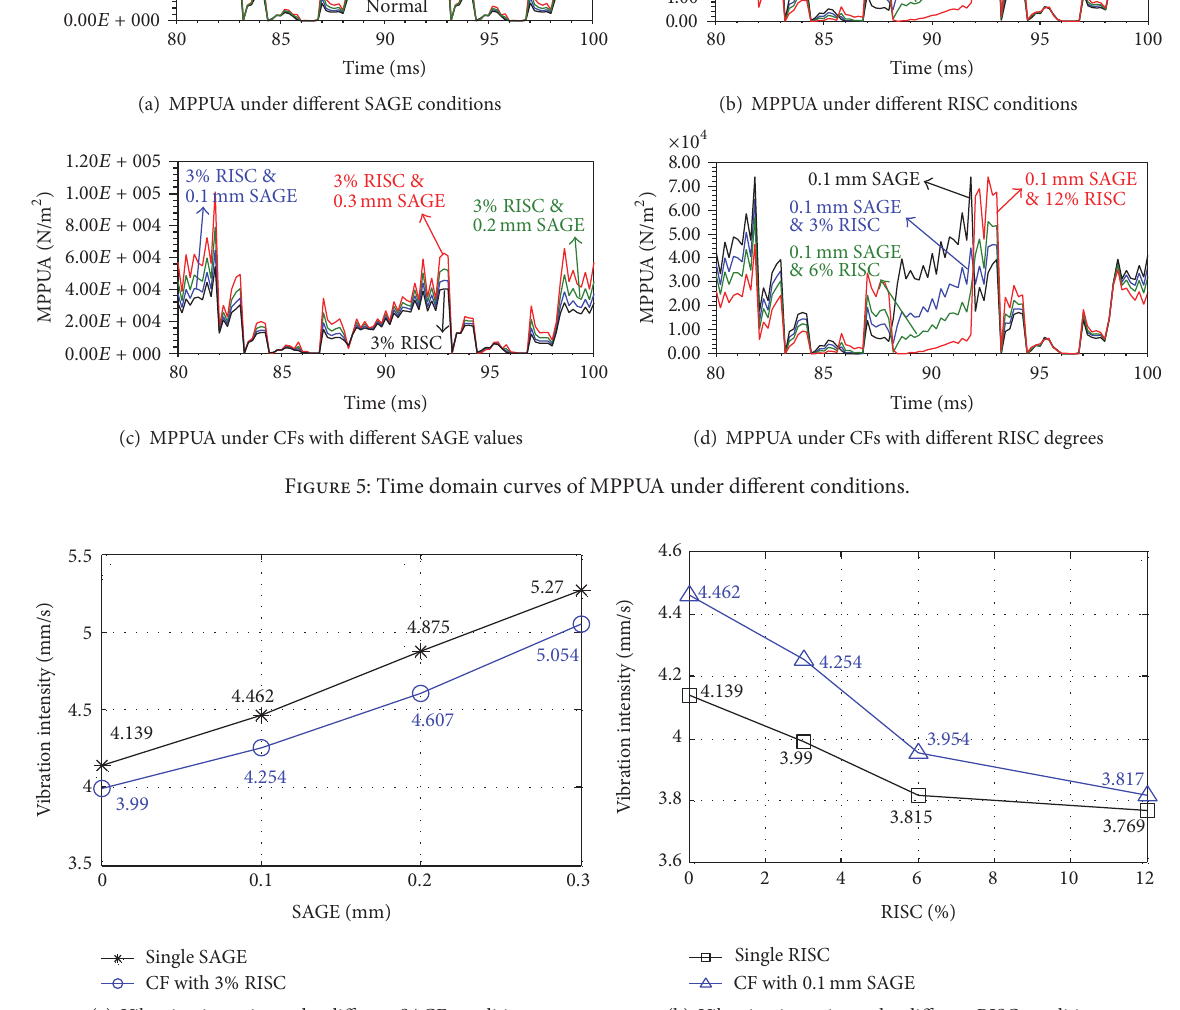
Figure 6: Vibration intensity under different performing